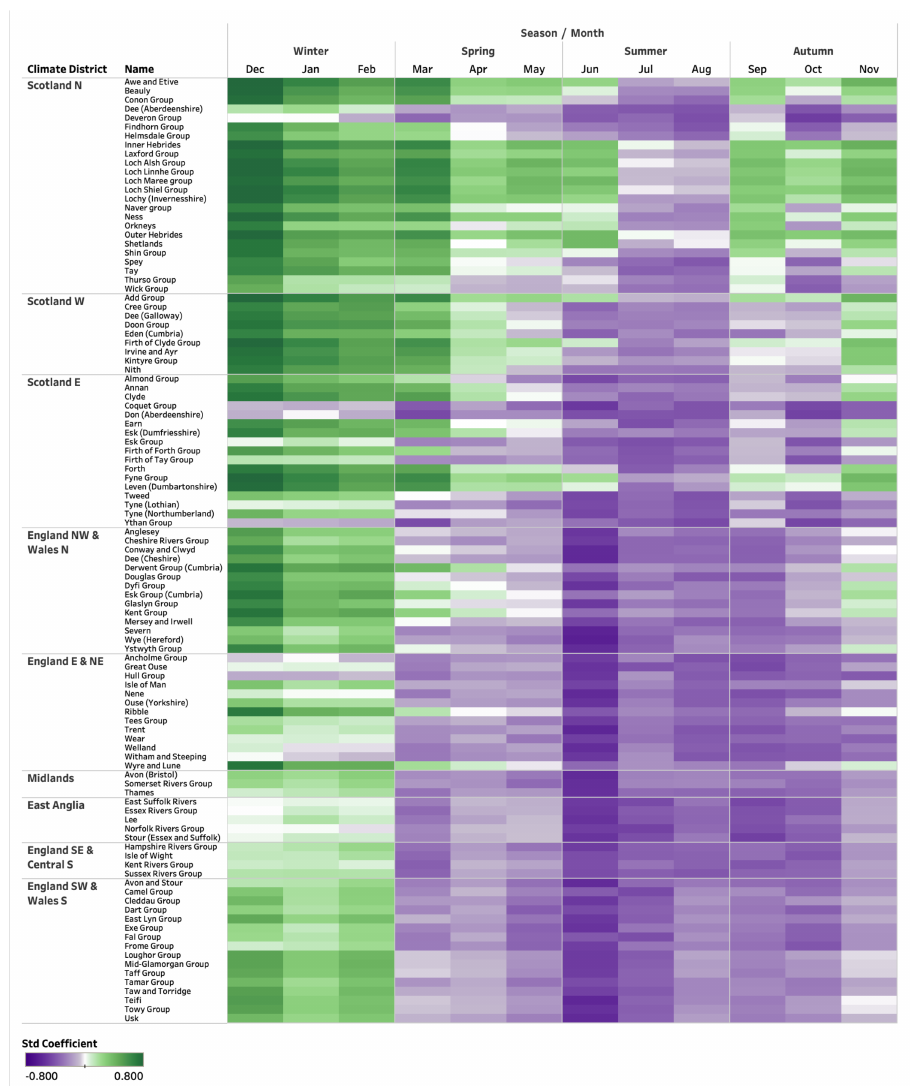
Figure 5. Standardised coefficient values for the NAO index from the multivariate regression